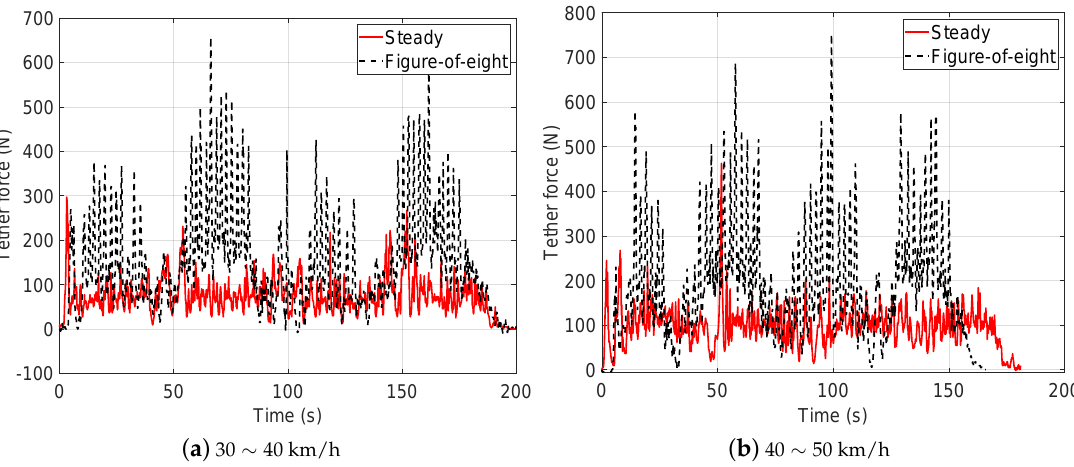
Figure 9. Effect of flight mode for tests 1 & 2 and 3 & 4.